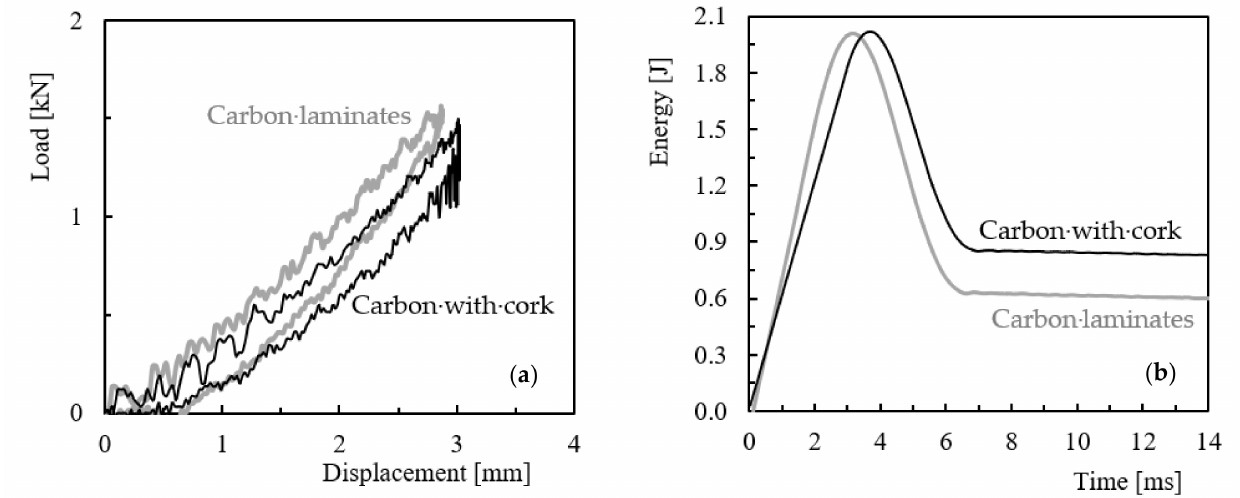
Figure 1. For an impact energy of 2 J, typical: ( a ) load versus time curves; ( b ) energy versus time